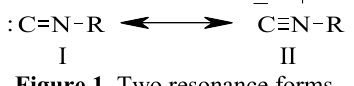
Figure 1. Two resonance